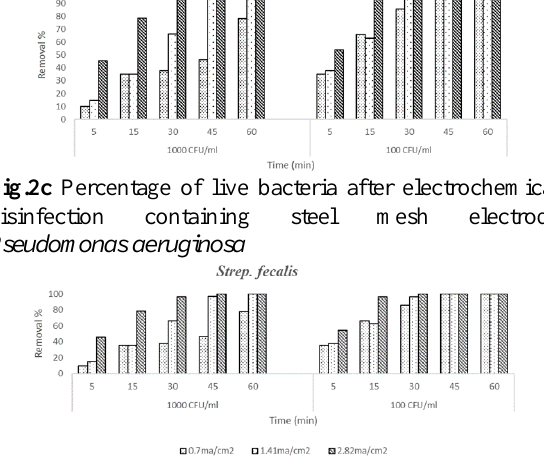
Fig.2c Percentage of live bacteria after electrochemical disinfection containing steel mesh electrode Streptococcus faecalis